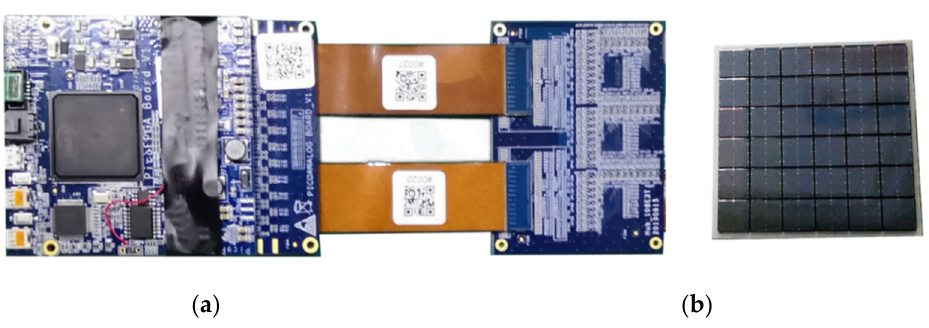
Figure 2. Pictures of ( a ) the custom-designed electronic system and ( b ) the SiPM array.